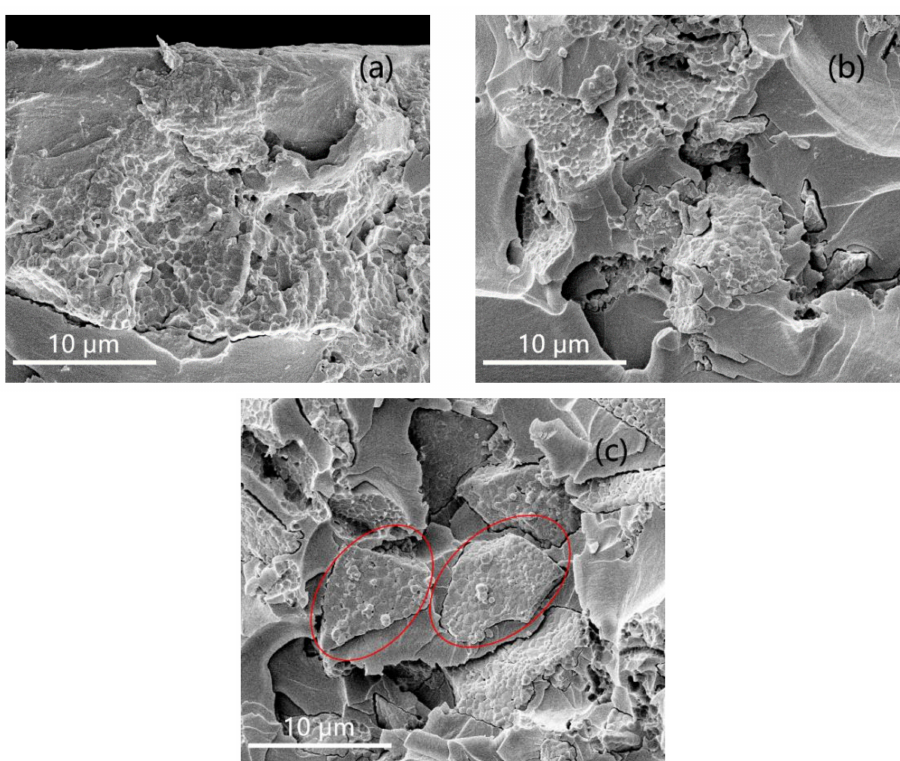
Figure 6. Dispersion of nano-filler in BFO/EP composites. ( a ) 2 wt% BFO/EP; ( b ) 8 wt% BFO/EP; ( c ) 16 wt%